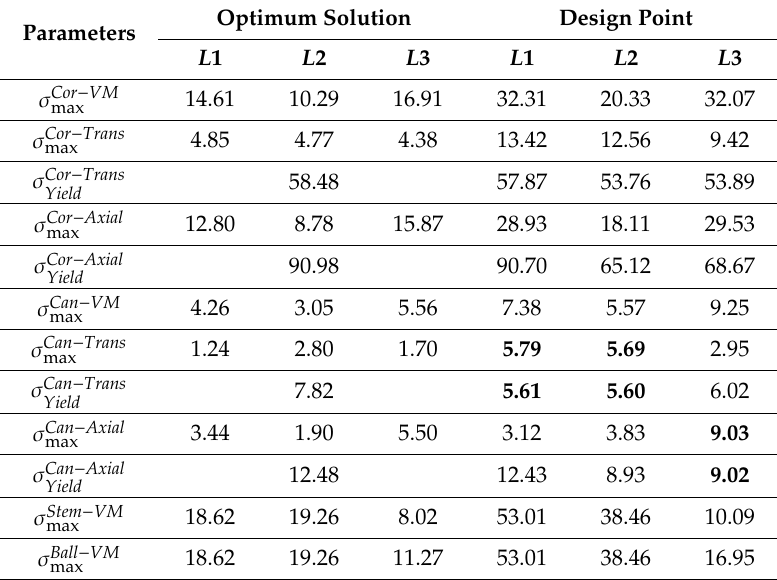
Table 6. Output parameters of the RBDO algorithm.